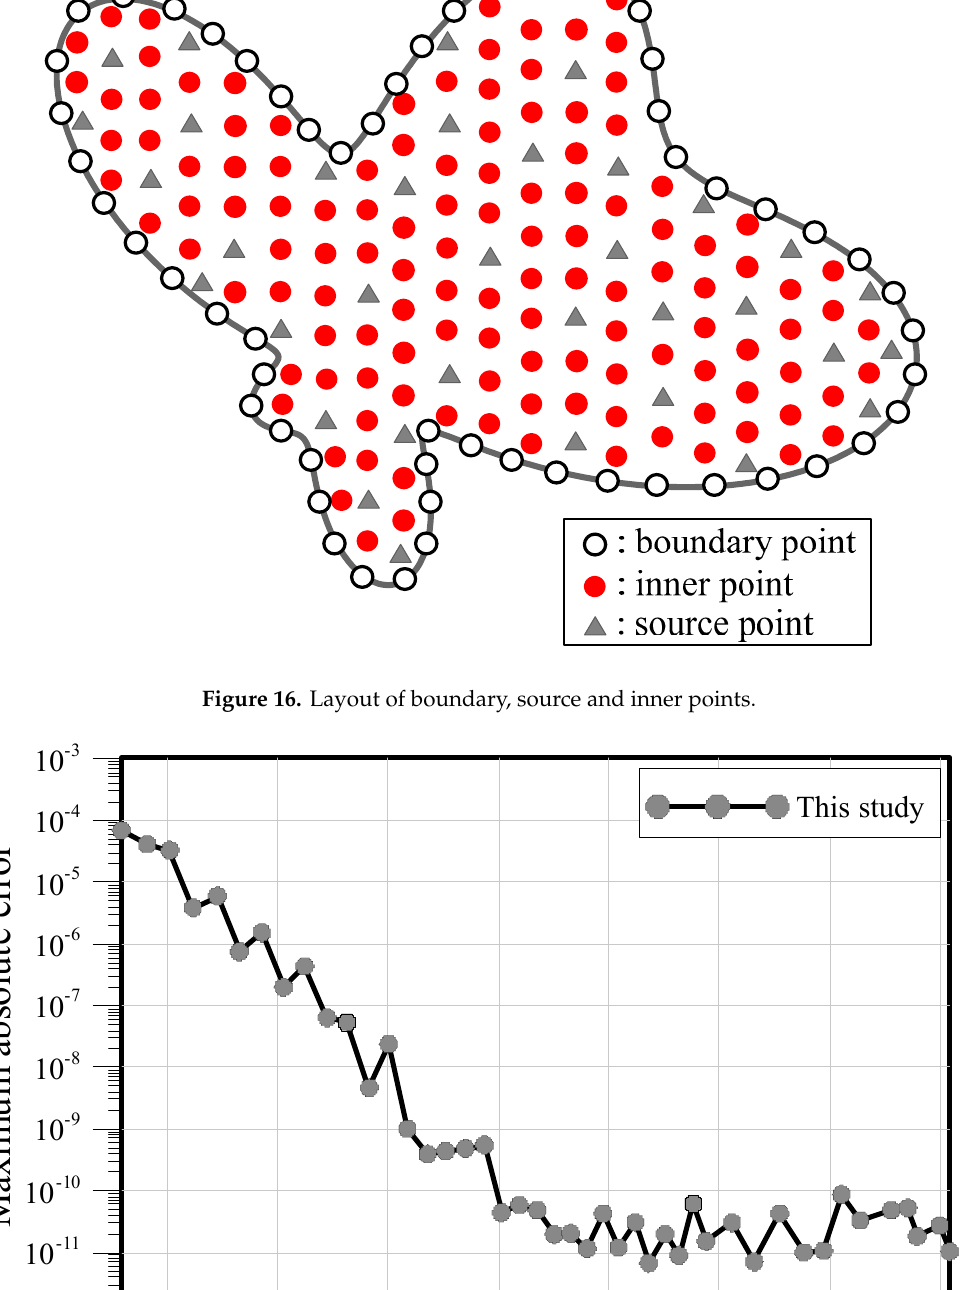
Figure 18. The number of inner points versus the maximum absolute error.